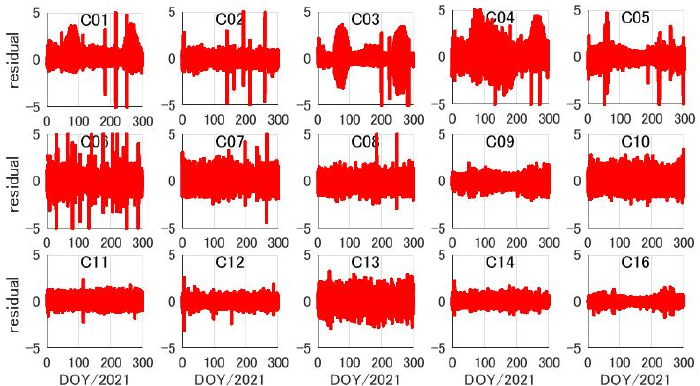
Figure 7. Fitting residual series of the BDS-2 onboard clocks from DOY 1 to 300, 2021 (units: ns).